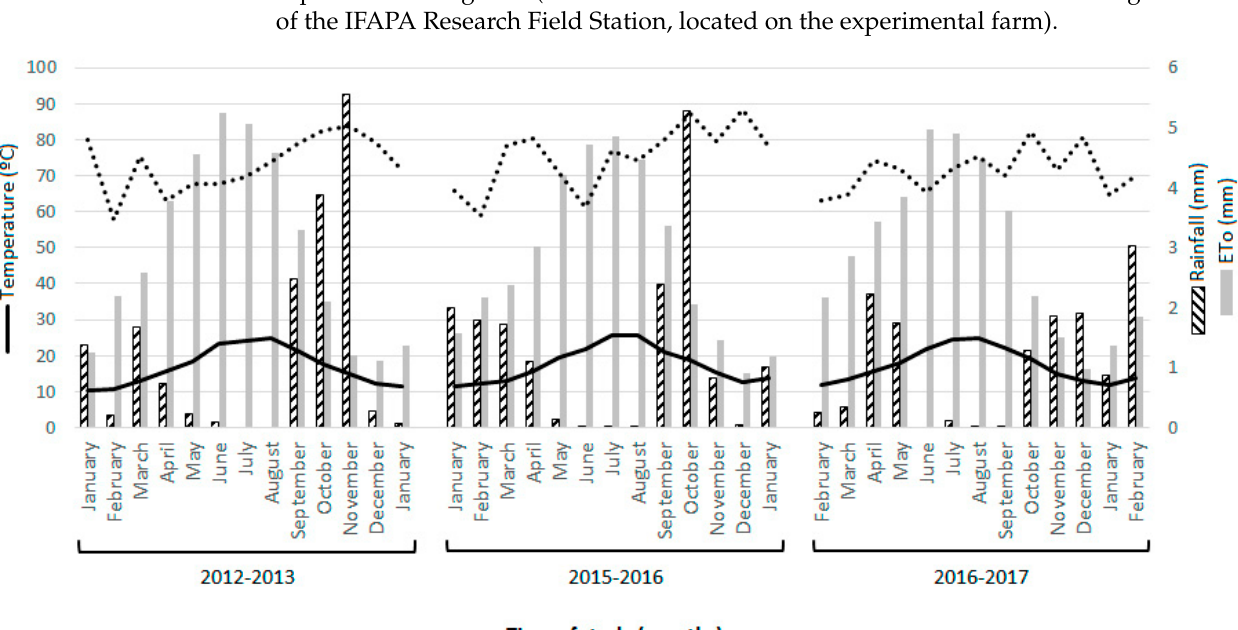
Figure 1. Relative humidity, temperature (left Y -axis), and rainfall reference evapotranspiration (eTo) (right Y -axis) averages per month during the study periods.